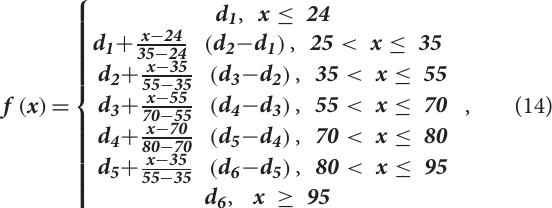
µ ( x 0 t , t ) across ages. ˜ +